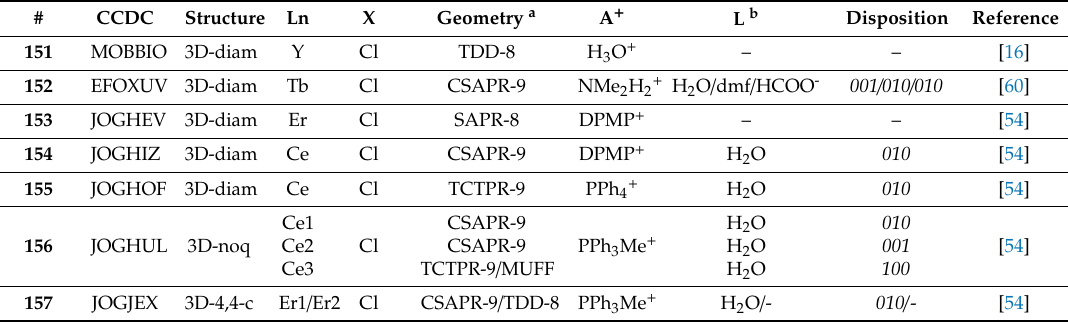
Table 7. Reported Ln-anilato complexes with 3D